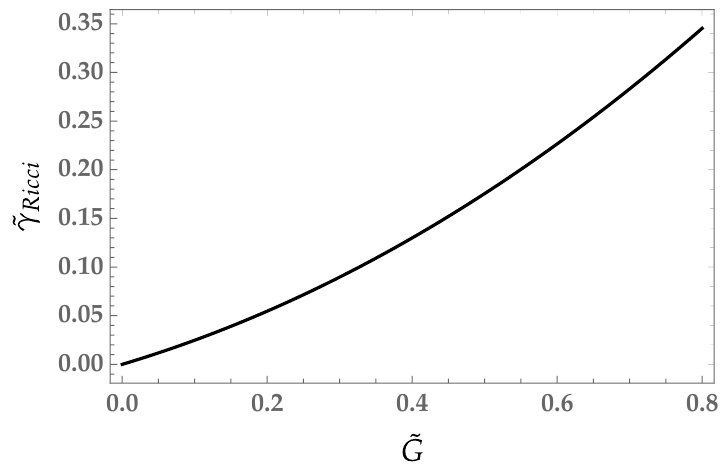
Figure 4. The gamma function ˜ γ Ricci in the order ∂ 4 approximation.